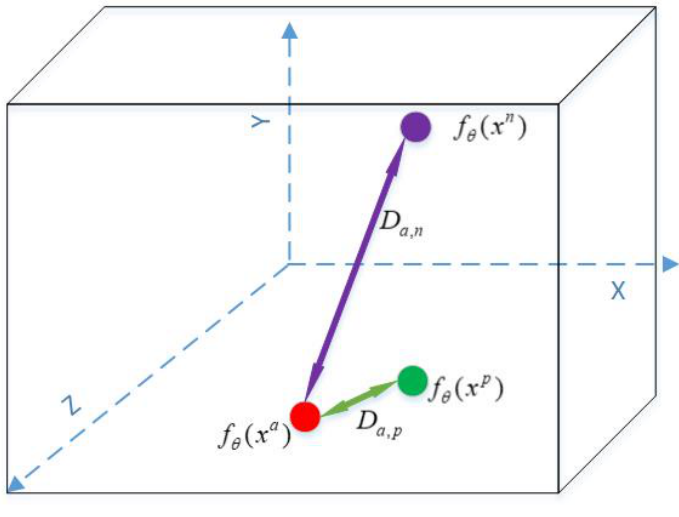
Figure 1. This is an example